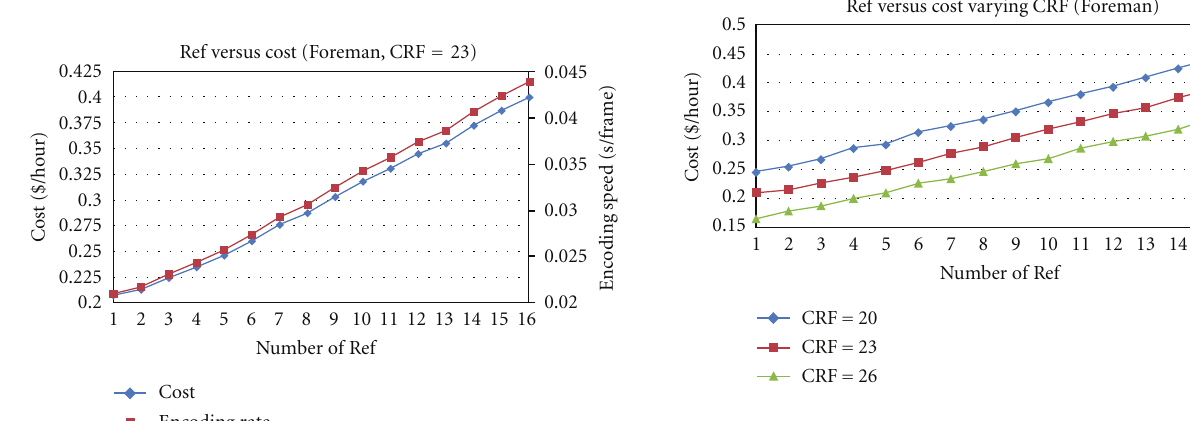
Figure 7: Encoding cost and rate with varying Ref number (Foreman, crf = 23).